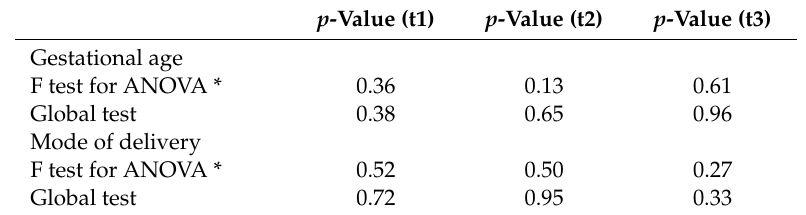
Table 3. F test for one-way ANOVA and global test for gestational age and mode of delivery at each predefined time